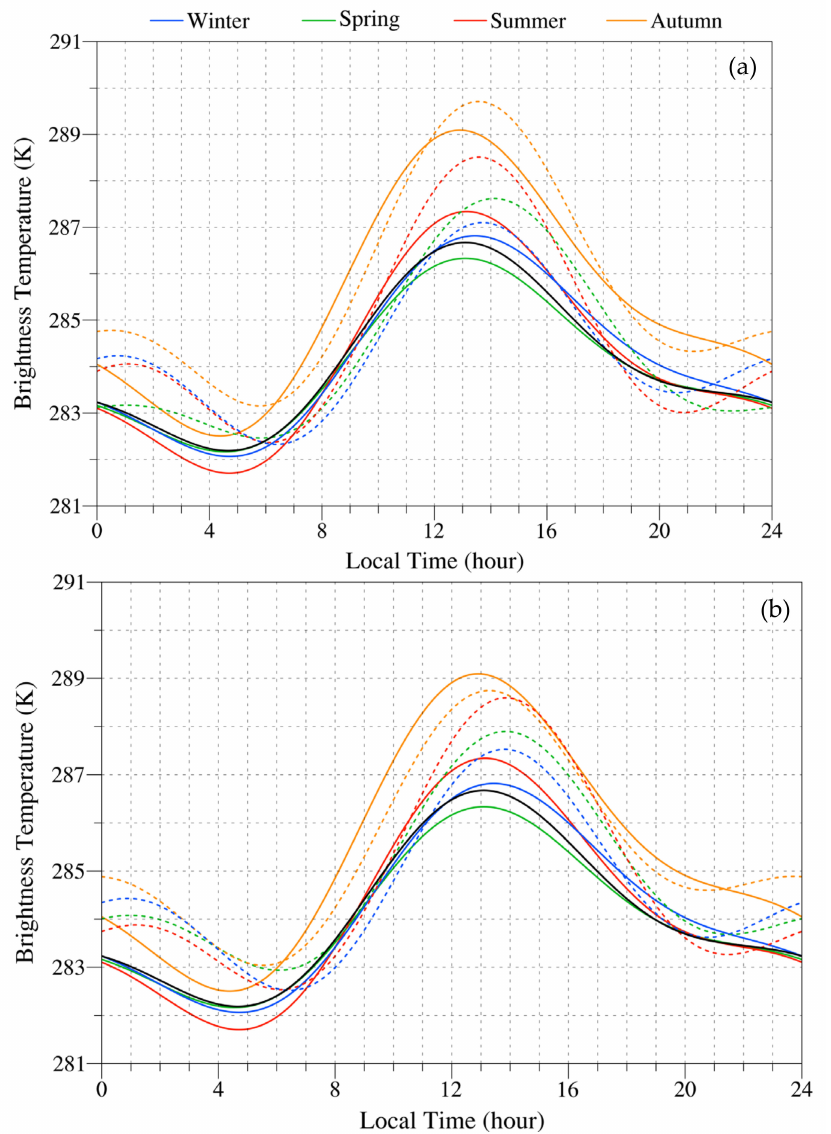
Figure 7. Diurnal variation of AMSU-A channel 3 from NOAA-15/18/19, MetOp-A/B, and FY-3D under “no-rain” conditions over the Amazon rainforest in ( a ) 2014 (solid curves) with 2019 (dashed curves) and ( b ) 2014 (solid curves) with 2020 (dashed curves). The black solid curve is the diurnal variation derived by all years’ spring